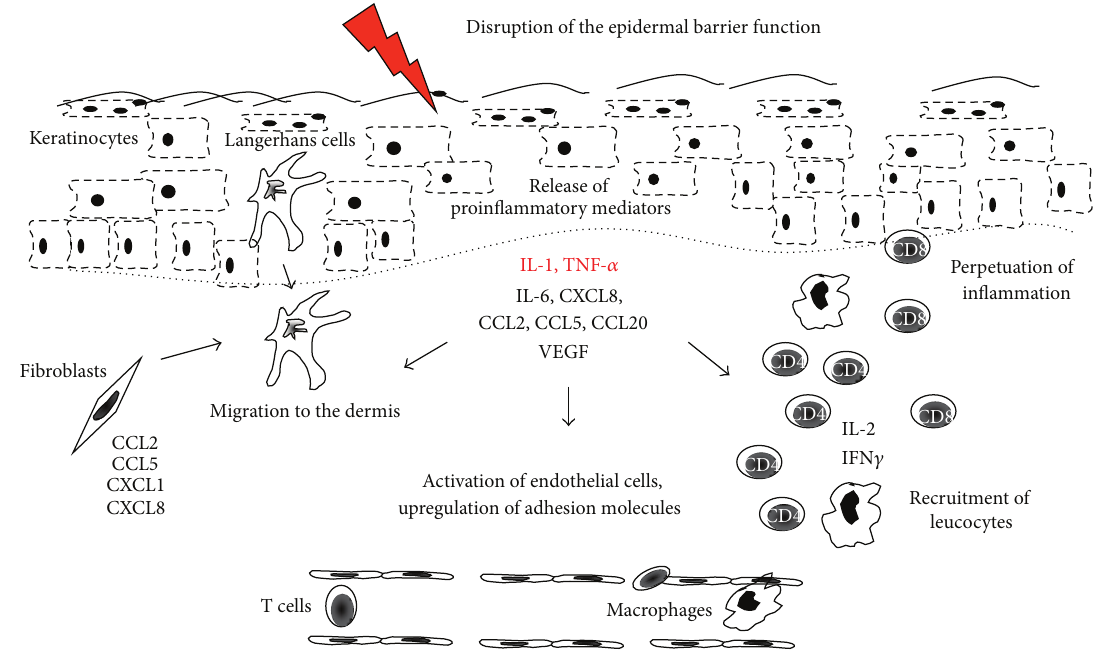
Figure 1: Immunological mechanisms in irritant contact dermatitis. Following irritant insult, there is disruption of the epidermal barrier with release of proinflammatory mediators, that is, IL-1 and TNF- 𝛼 . This results in stimulation of further cytokine and chemokines production, for example, by keratinocytes, fibroblasts, and endothelial cells, upregulation of adhesion molecules on endothelial cells, and the subsequent recruitment of leucocytes thereby perpetuating ongoing